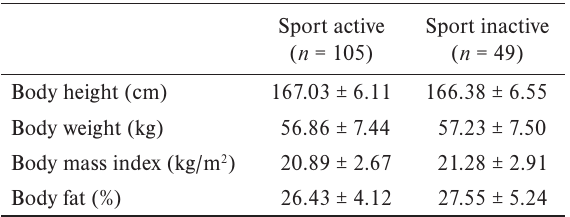
Mean ± SD of basic anthropometric parameters in sport active and inactive